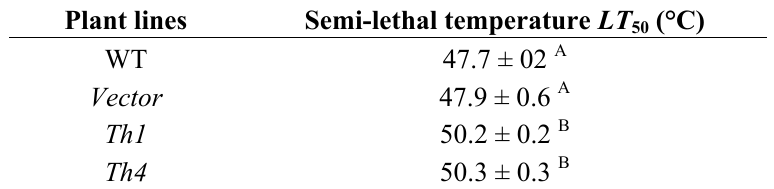
) of transgenic plants and non-transgenic 50